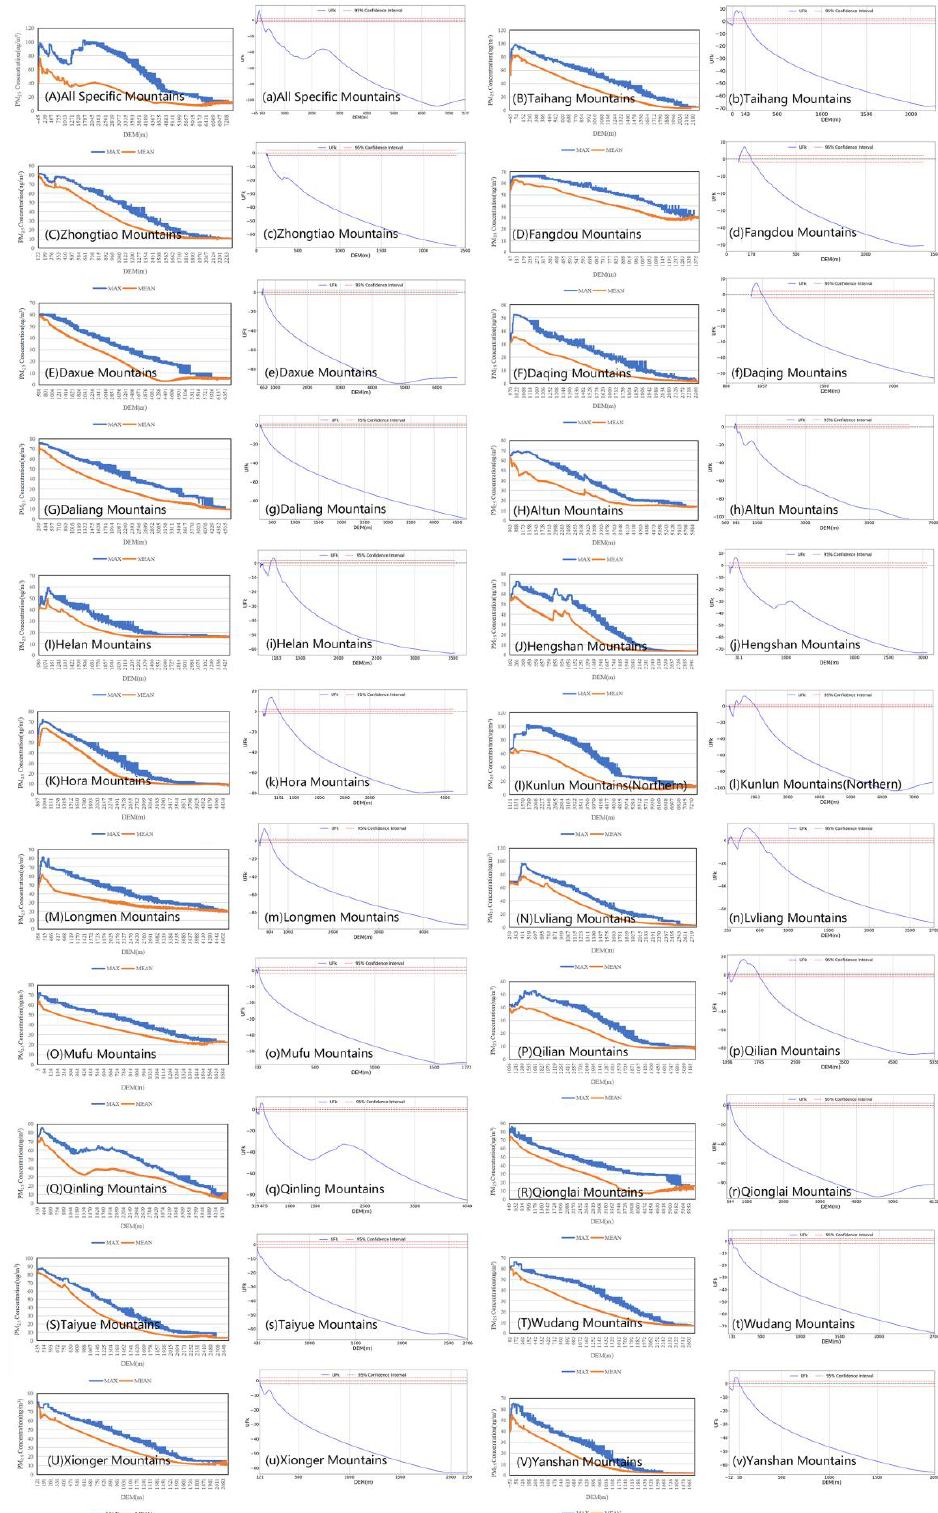
Figure 8. The changing curves between the mean and maximum PM 2.5 concentrations and the DEM values ( A – V ), and the corresponding trend detection in mean PM 2.5 concentrations by M-K test ( a – v ) for the typic mountains. The mean PM 2.5 concentrations (the orange lines) were the average PM 2.5 concentrations based on pixels of each DEM value; analogously, the max PM 2.5 concentrations (the blue lines) were the maximum PM 2.5 concentrations based on pixels of each DEM